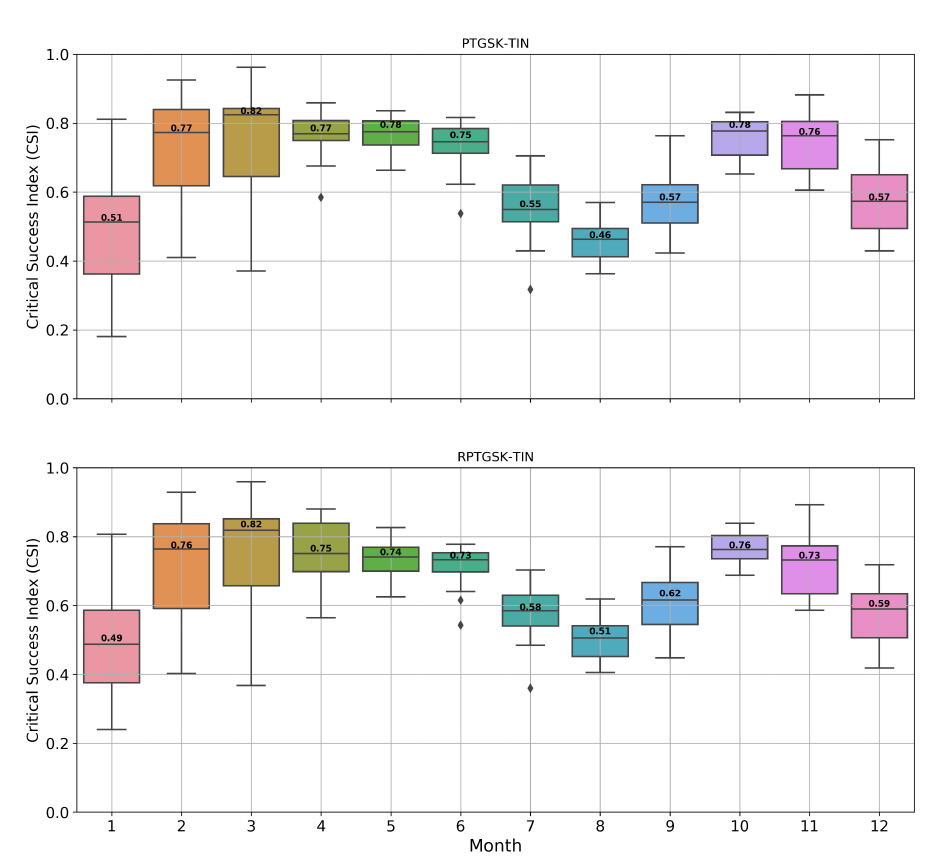
Figure 9. Monthly Critical Success Index calculated for models (PTGSK-TIN, and RPTGSK-TIN). Numbers inside boxplot represent median